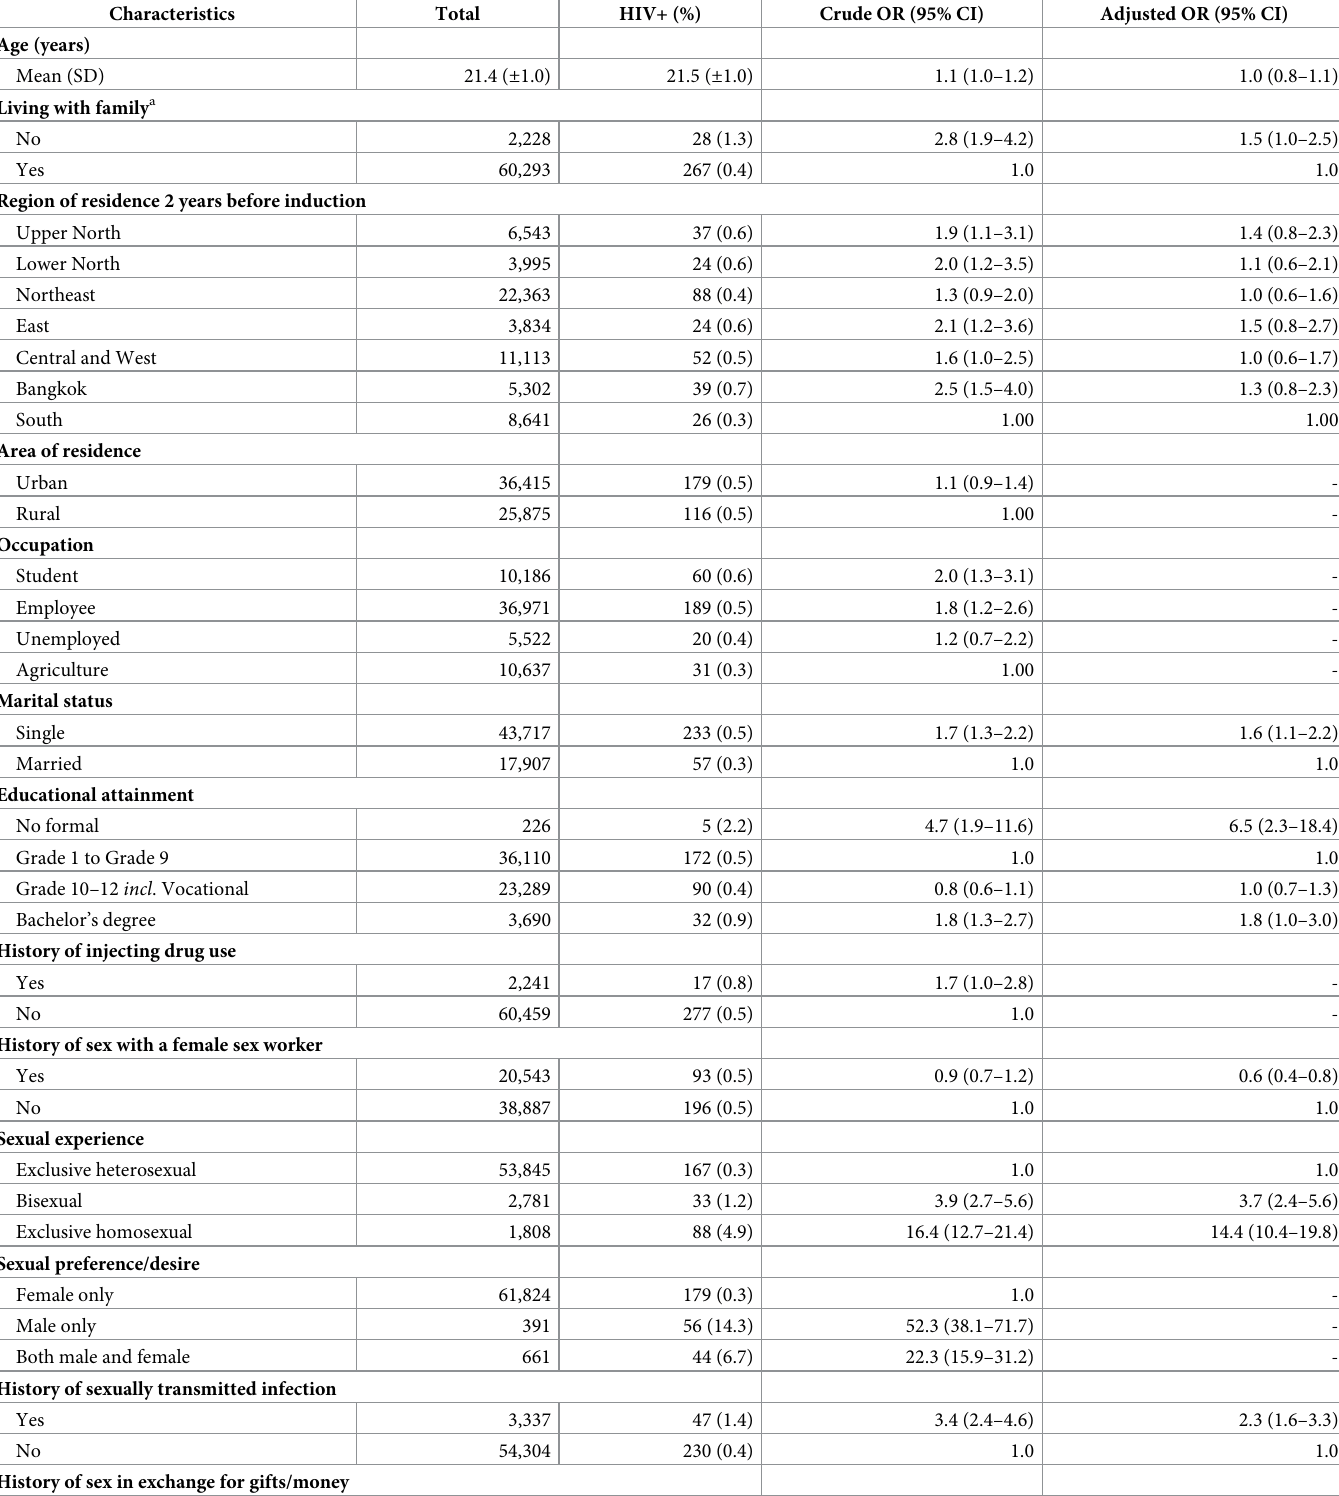
Table 2. Univariate and multivariate analysis of risk factors to HIV infection among the participants inducted into the RTA in November 2010 and May 2011.